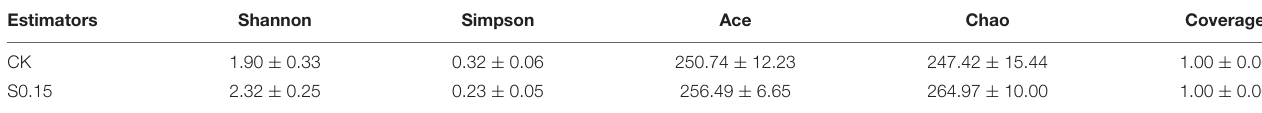
TABLE 1 | Diversity indexes of the gut bacteria of zebrafish fed with the CK or S0.15 for 4 weeks. Estimators Shannon Simpson Ace Chao Coverage